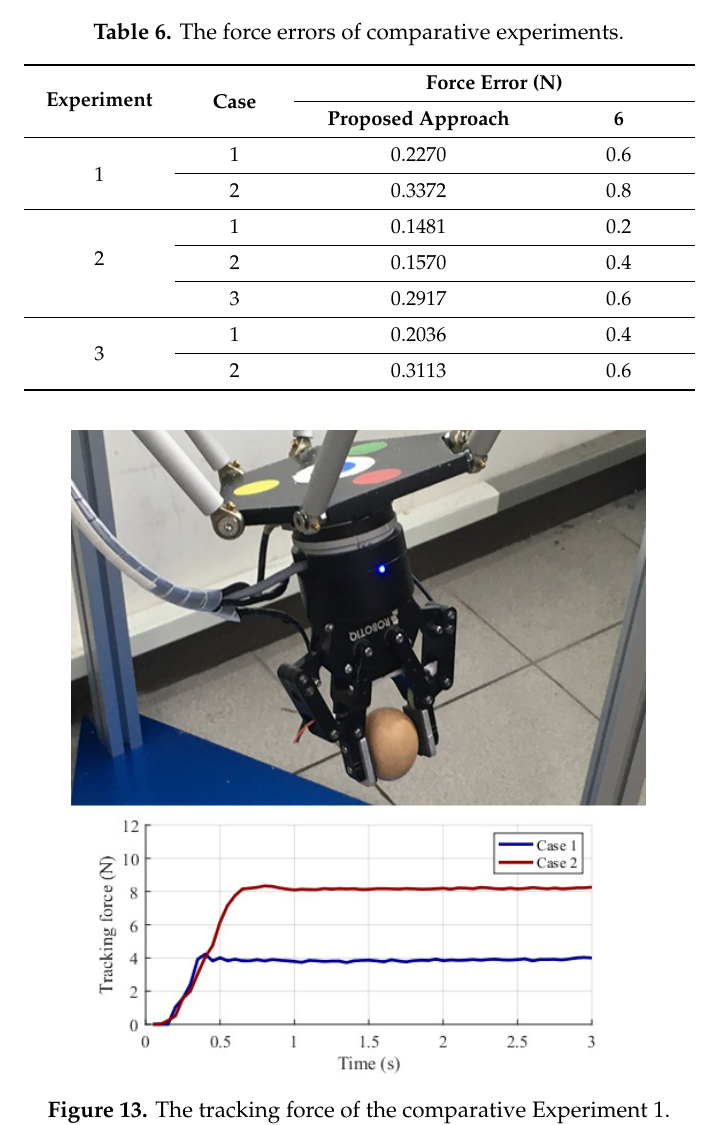
Figure 14. The tracking force of the comparative Experiment 2.